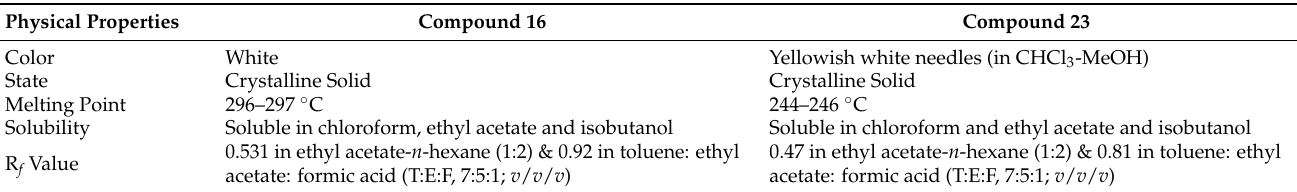
Table 2. Characterization of the Isolated